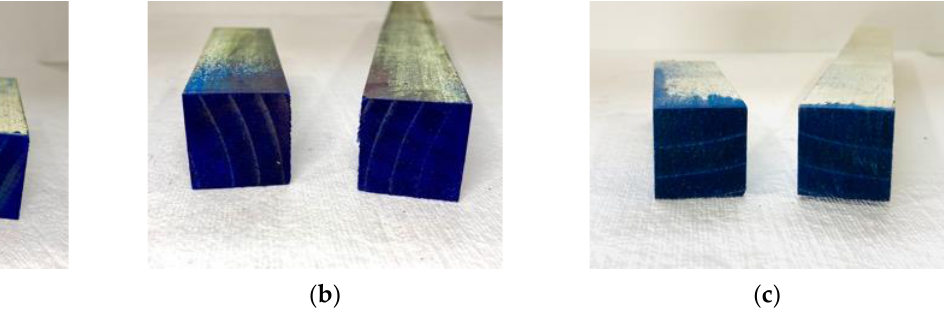
Figure 2. Copper penetration in treated wood. Blue color indicates copper in ( a ) K1 CuNP-treated wood, ( b ) K2 CuNP-treated wood and ( c ) micronized-copper-treated wood.